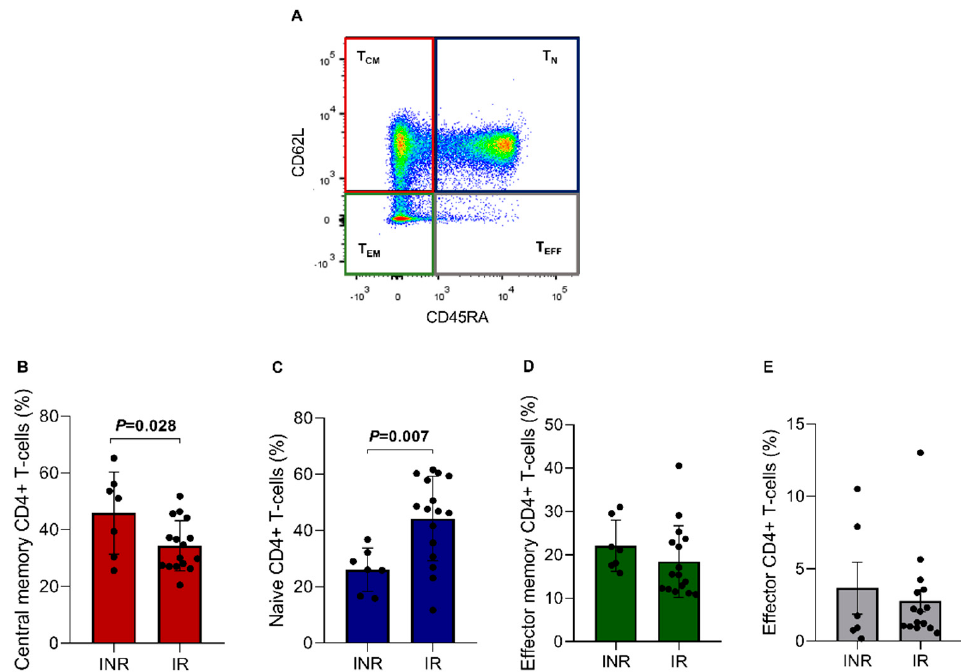
Figure 4. CD4+ T lymphocytes subsets in the INR and IR groups. ( A ) Lymphocytes were gated on CD4+ T cells and then on CD45RA and CD62. ( B ) T CM = central memory CD4+ T cells (CD45RA- CD62L+); ( C ) T N = naïve CD4+ T cells (CD45RA+ CD62L+); ( D ) T EM = effector memory CD4+ T cells (CD45RA- CD62L-); and ( E ) T EFF = effector CD4+ T cells (CD45RA+ CD62L-). Means, standard deviation, and p -values (according to the t -test) are shown. INR—immunological non-responders. IR— immunological responders.